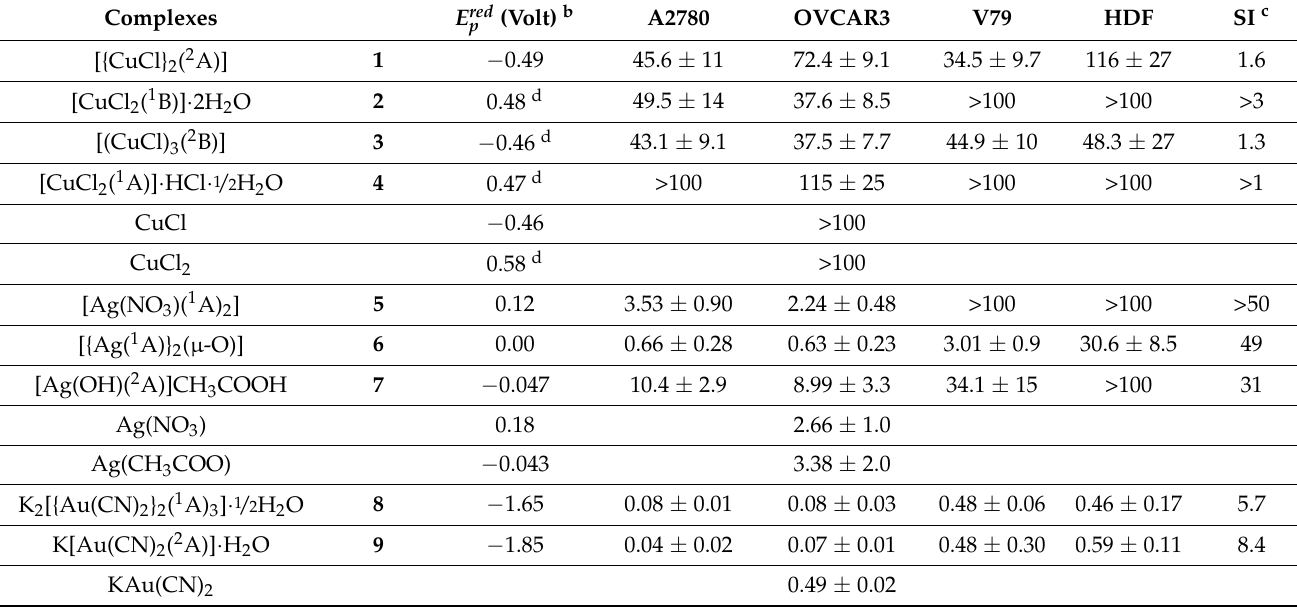
Table 1. IC 50 values a and reduction potentials for the camphorimine